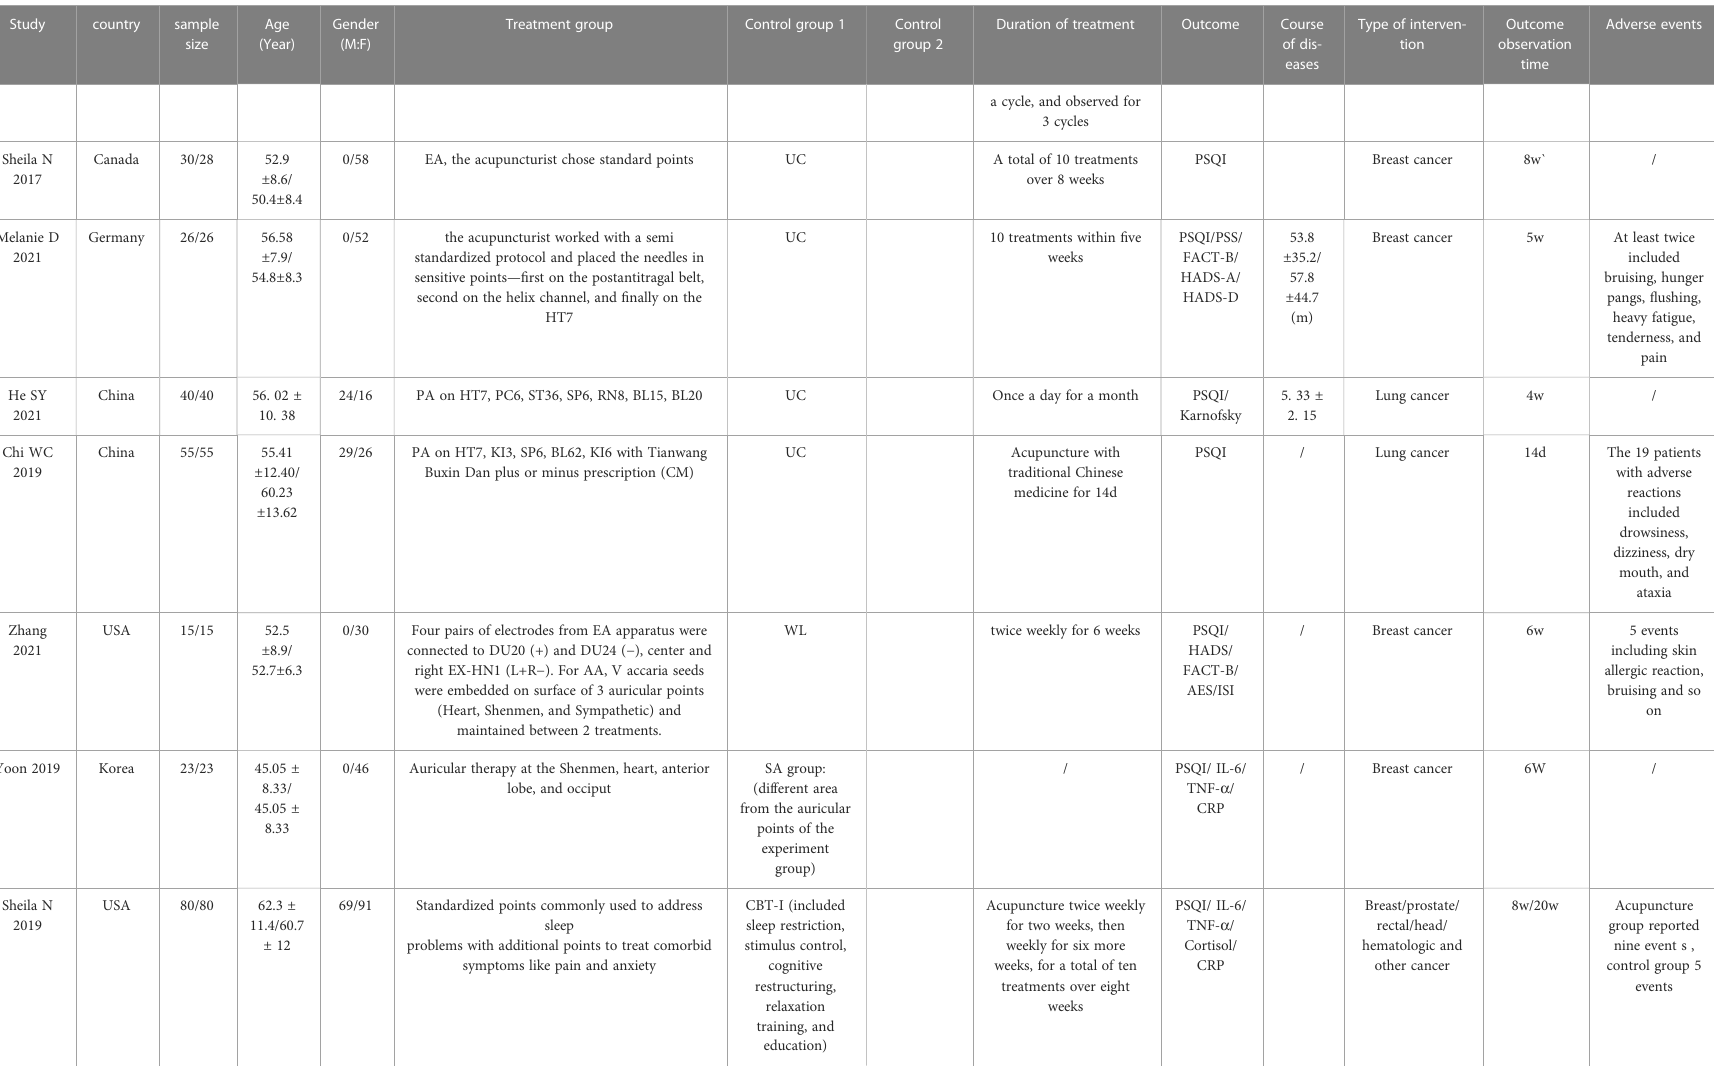
Standardized points commonly used to address sleep problems with additional points to treat comorbid symptoms like pain and anxiety